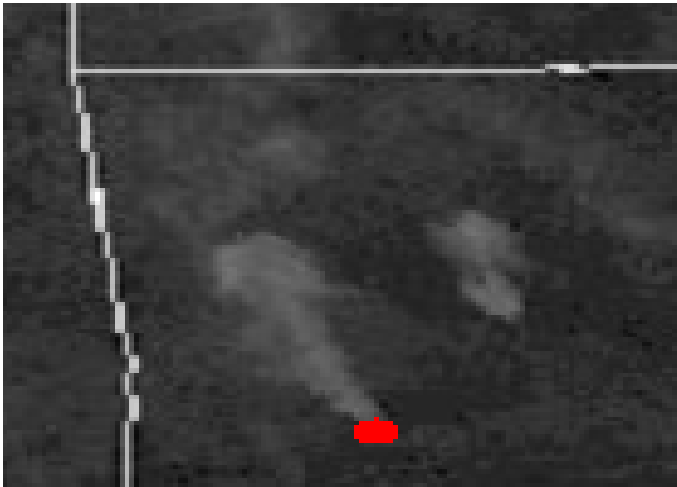
Figure 1. 1515 LST GOES image of the smoke plume from the 27 February 2004 Magazine Mountain, AR, prescribed burn (red area).